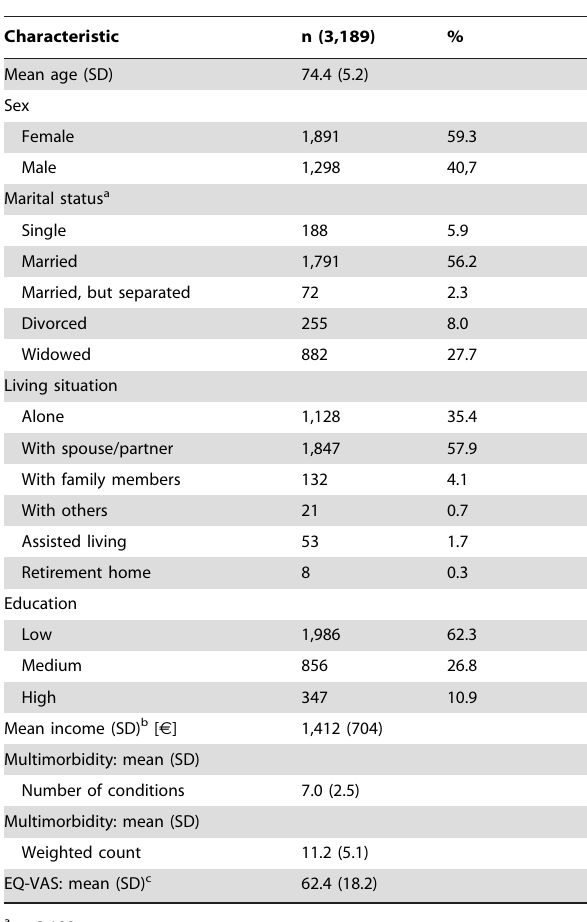
Table 1. Sociodemographics characteristics and